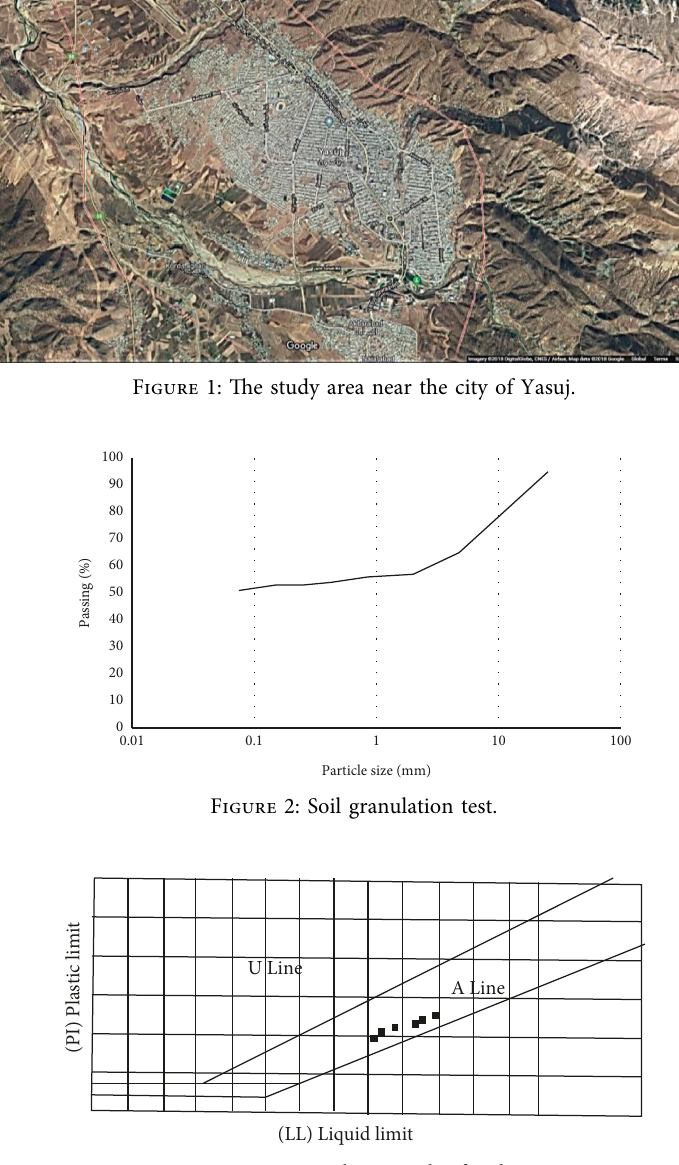
Figure 3: Atterberg result of